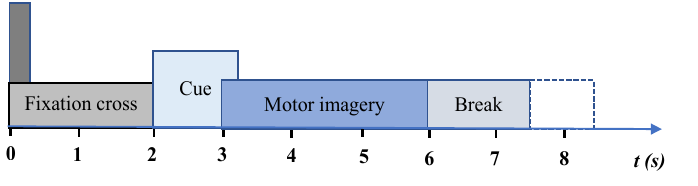
Figure 2. The paradigm time sequence.